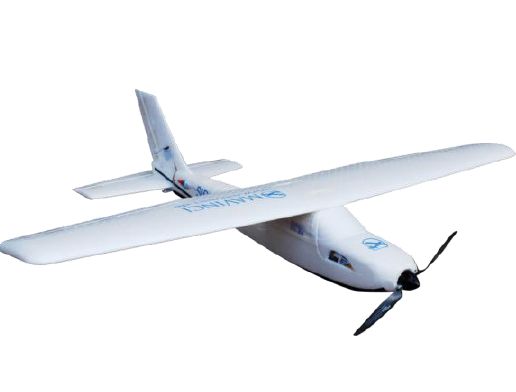
Figure 2. Mavinci fixed wing UAV